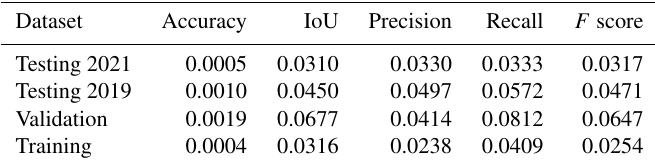
Table A7. Standard deviation of performance metrics between folds, calculated using area.